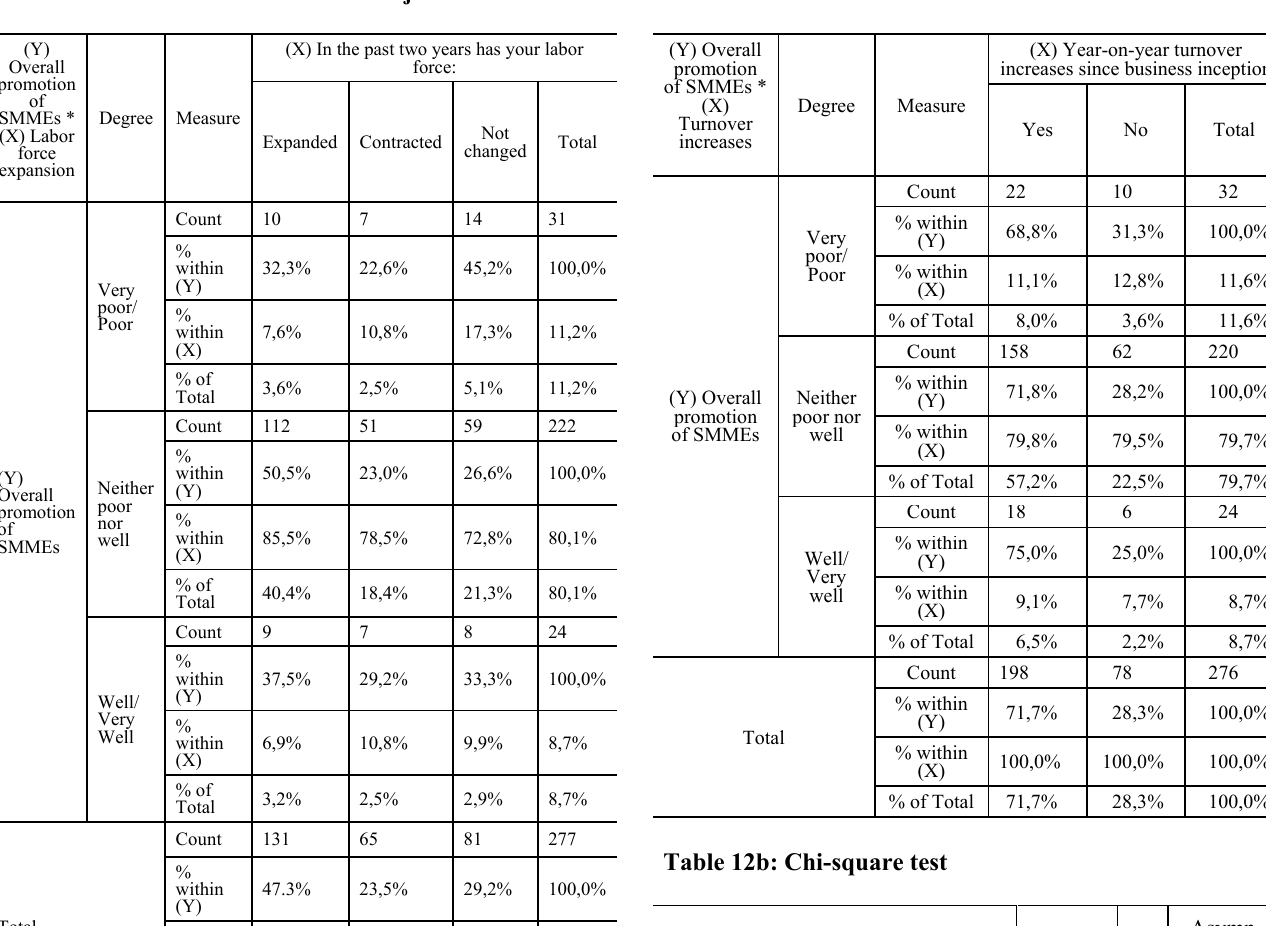
Table 11a: Promotion of SMMEs and job creation